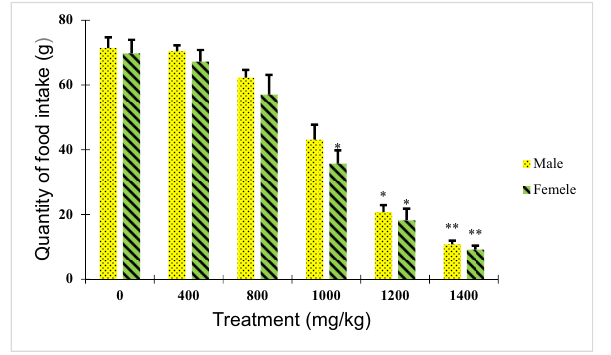
Figure 5: E ff ect of B. hispanica extracts on the bodyweight of male rats treated with a dose up to 14,000